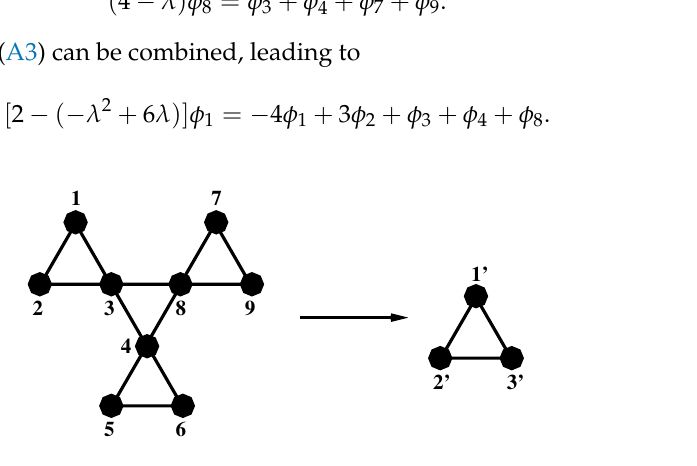
Figure A1. First